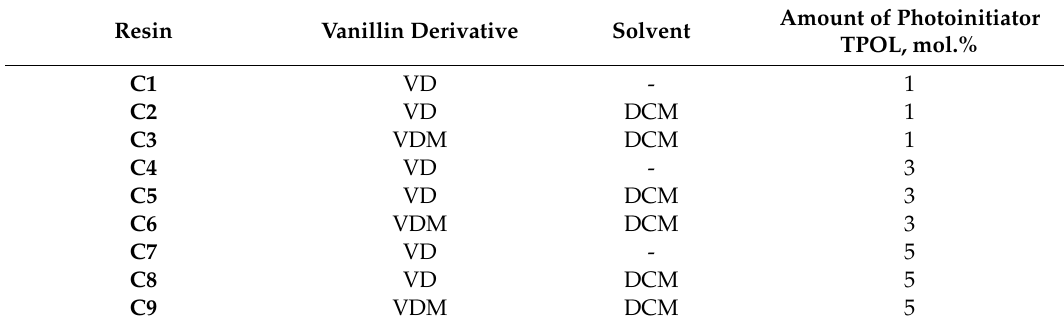
Table 1. Composition of the resins C1 – C9 .